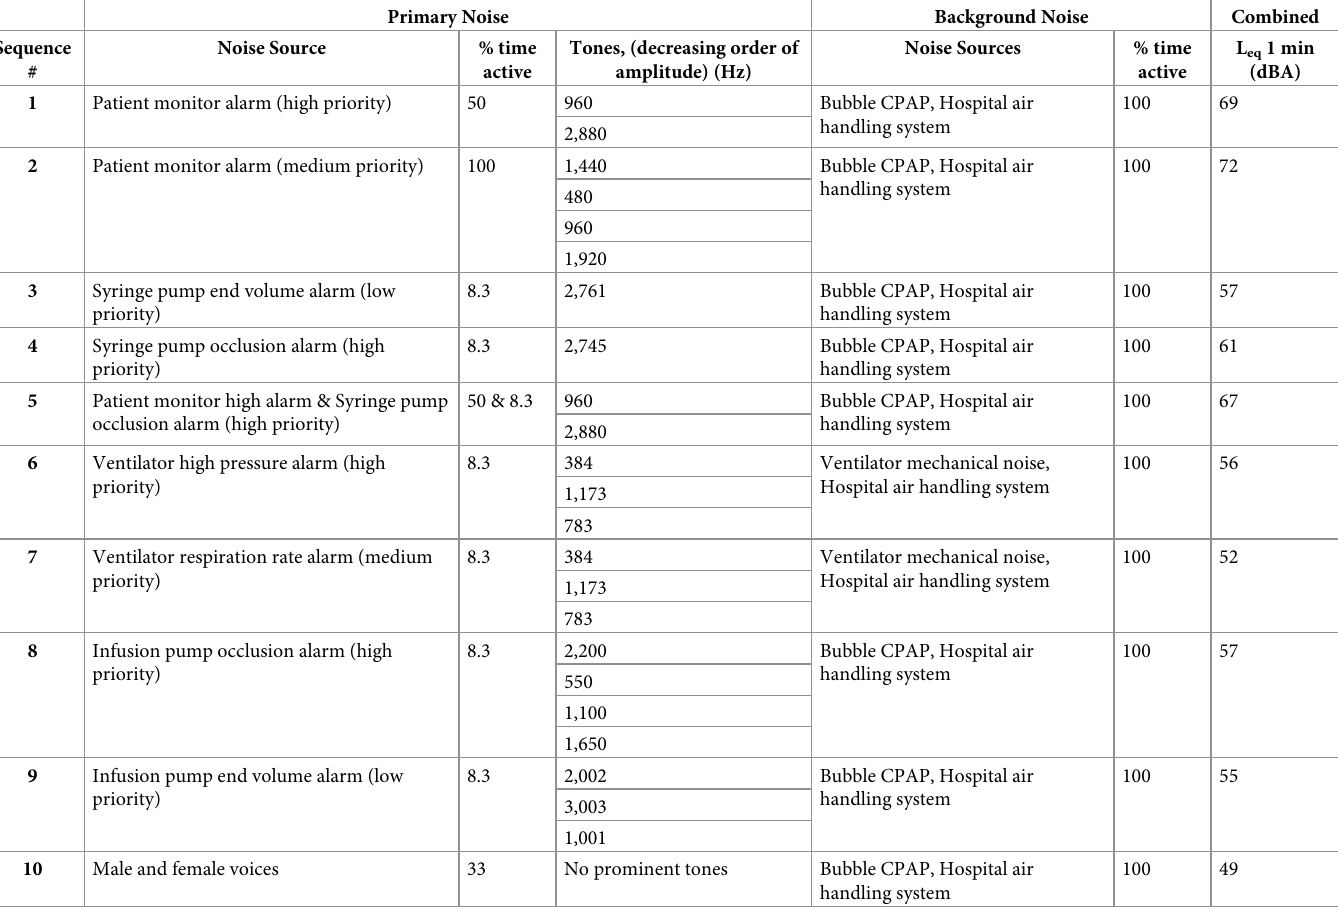
Table 1. NICU sound sequences used for